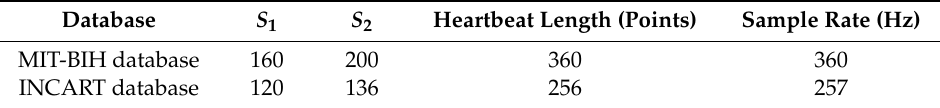
Table 2. Length of a heartbeat in MIT-BIH database and INCART database.